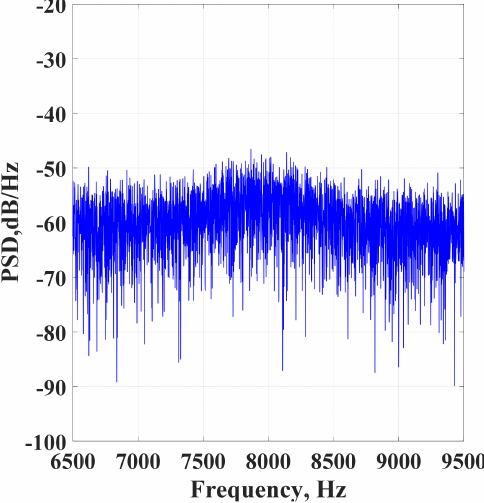
Figure 9. The sideband current harmonics with the HCFM.